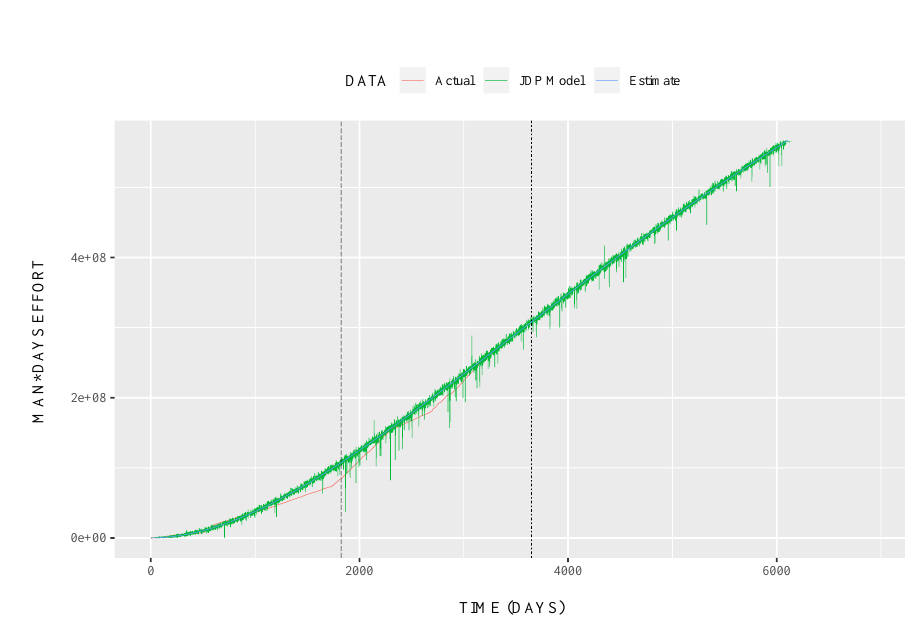
Figure 3. The estimated cumulative OSS maintenance effort expenditures for 𝐸